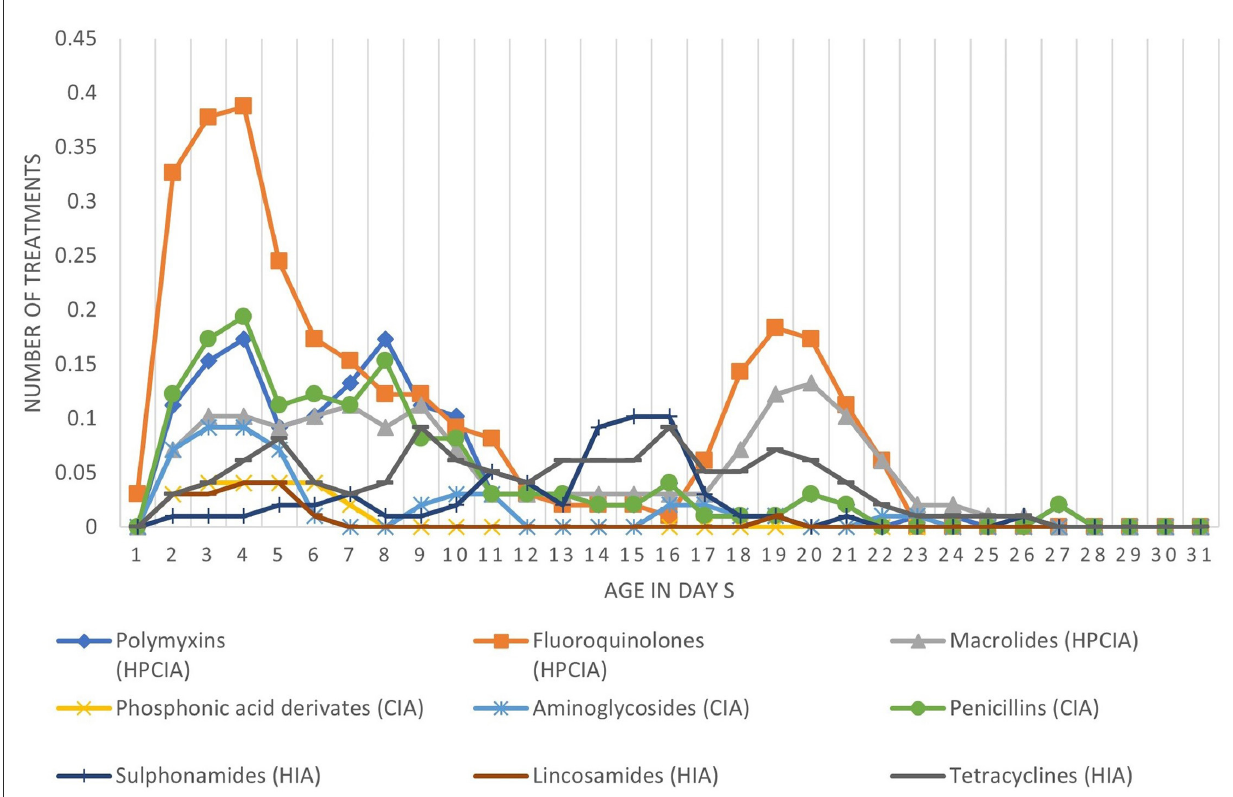
FIGURE1 Average number of antimicrobial treatments per broiler per day of age divided in the different antimicrobial classes.